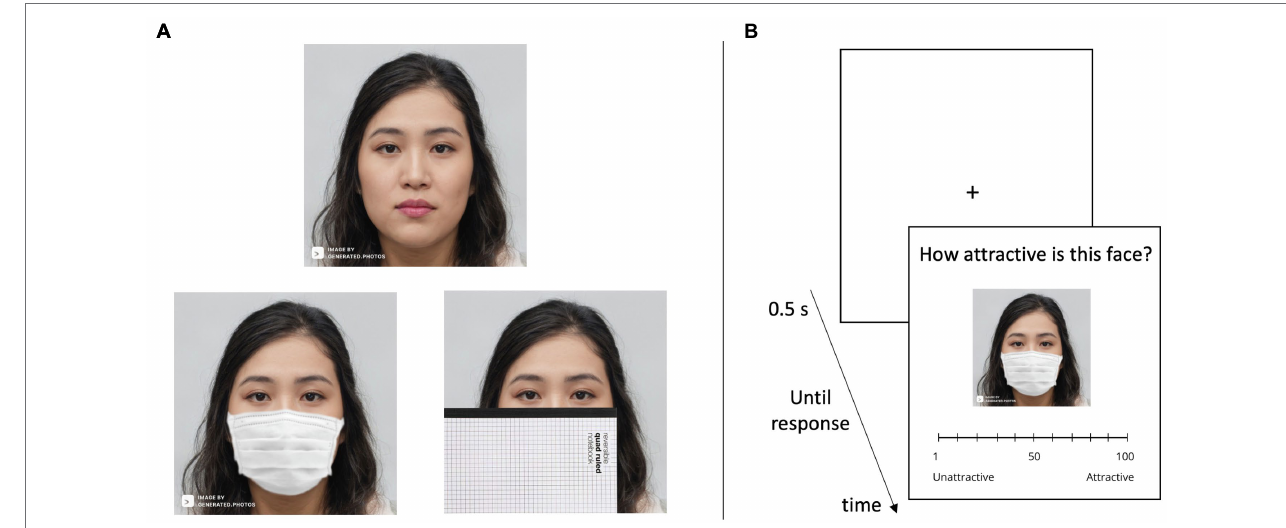
FIGURE 1 | (A) Examples of an unmasked Asian face shown together with the same face when masked (Experiment 1) or when partially occluded by a notebook (Experiment 2). (B) The trial event sequence in the study. The image depicted in the figure was computer generated for the purposes of illustration (https:// generated.photos/) and was not one of the faces used in the